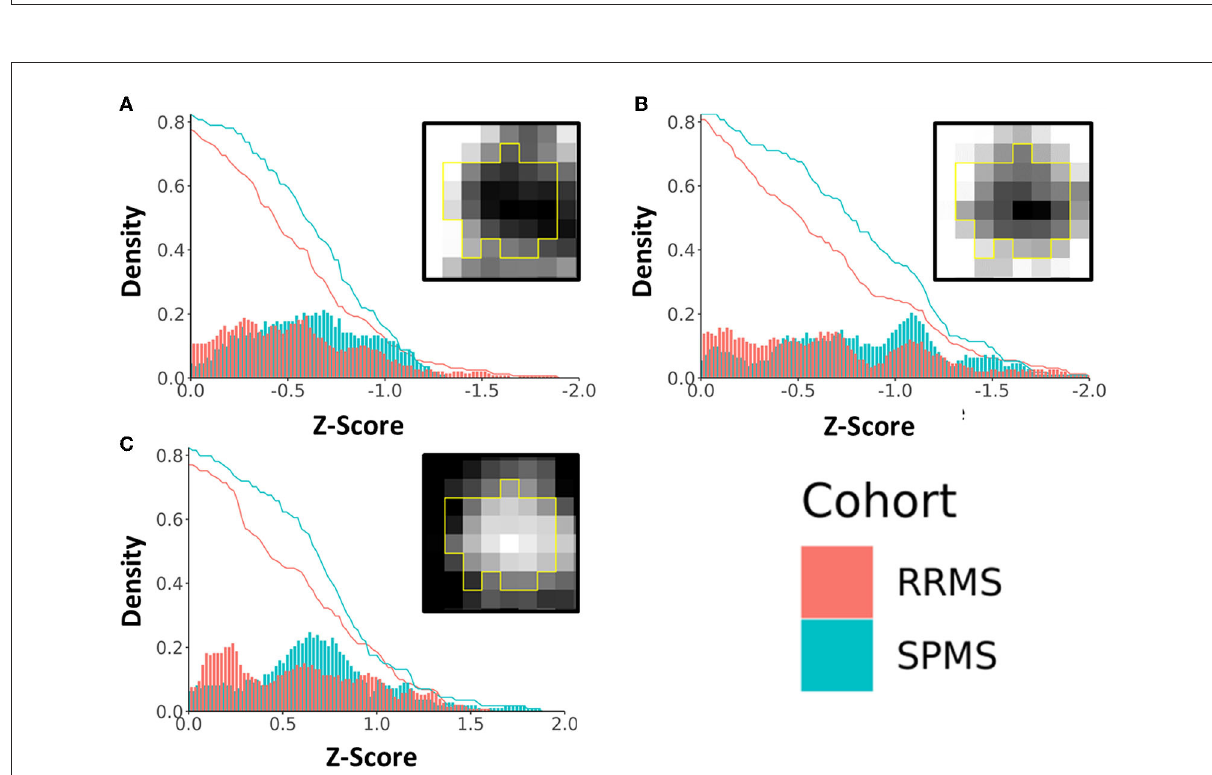
FIGURE7 Density plot of chronic active lesions per cohort based on a common range of z-scores of diffusion metrics. Shown are results based on (A) fractional anisotropy (FA), (B) intracellular volume fraction (ICVF), and (C) axonal diameter. The histograms (bin size = 0.02) represent the percentage of chronic active lesions, and the red and blue curves represent the accumulated probability of the lesions with equal or more extreme z-scores. The boxed images show example lesion maps of the corresponding diffusion